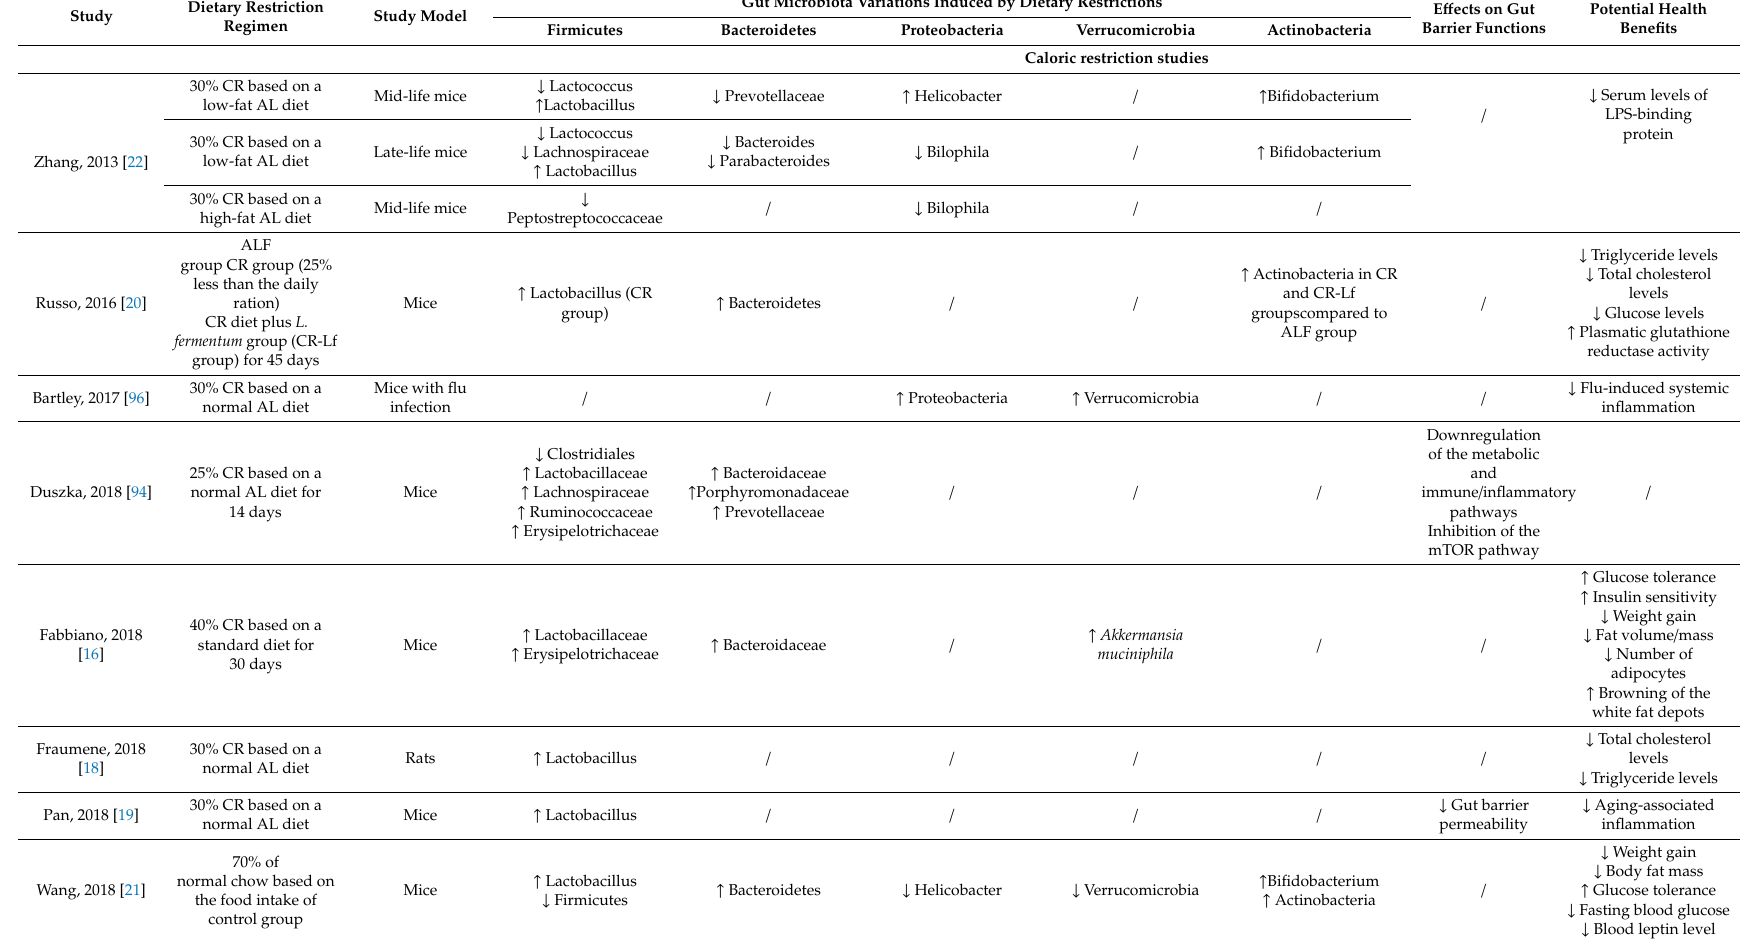
Table 1. Overview of studies investigating the possible correlations between gut microbiota variations, gut barrier permeability, and health benefits induced by dietary